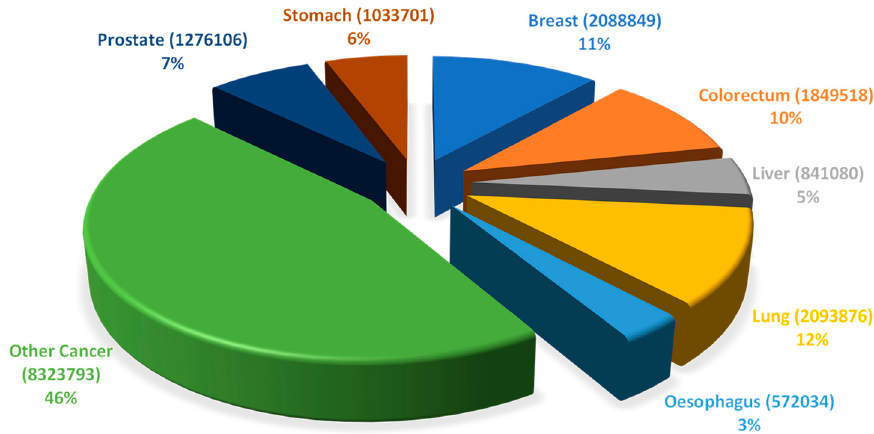
Figure 1. Distribution of the estimated number of worldwide cancer cases in 2018 (18,078,957) per type of cancer. Data includes all types of cancers, all ages and both sexes (Adapted from Global Cancer Observatory—World Health Organization [2]).